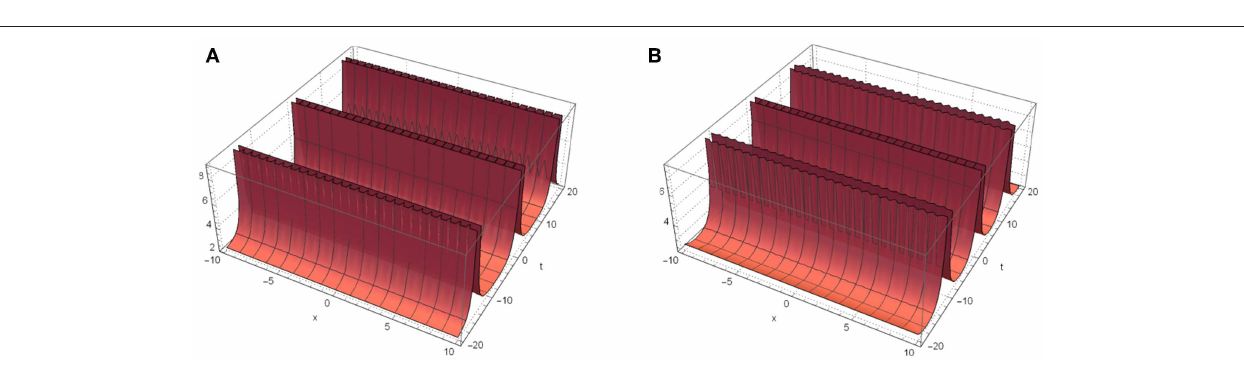
5 √ 3 k 2 = − 63 √ k 3 k 4